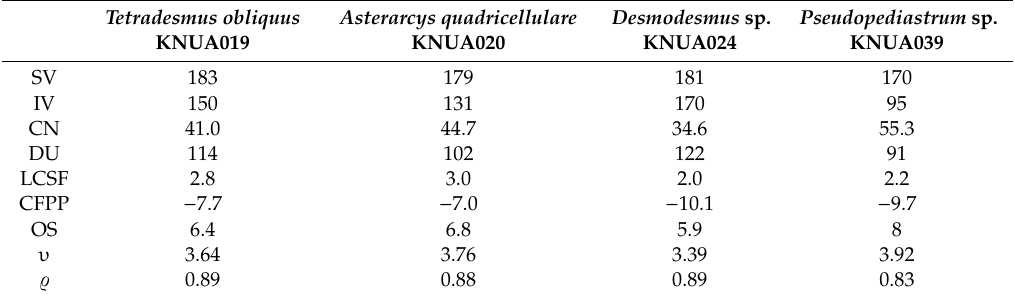
Table 4. Biodiesel properties of microalgal biomass in treated, primary settled wastewater, calculated by fatty acid methyl-ester composition.